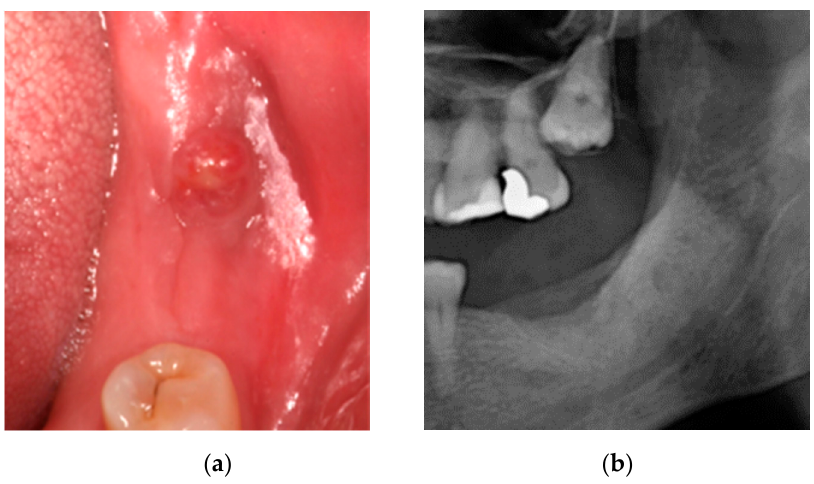
Figure 3. ( a ) Fistula in the jaw and ( b ) X-ray of the affected area. Immediate conservative treatment included amoxicillin/clavulanic acid (2000 mg + 125 mg every 12 h for 15 days) (Augmentin Plus, GSK, Madrid, Spain) and 0.12% chlor- hexidine rinses (Perio-Aid, Dentaid, Barcelona, Spain) every 12 h for 30 days. The rheu- matologist was consulted to discontinue bisphosphonates.